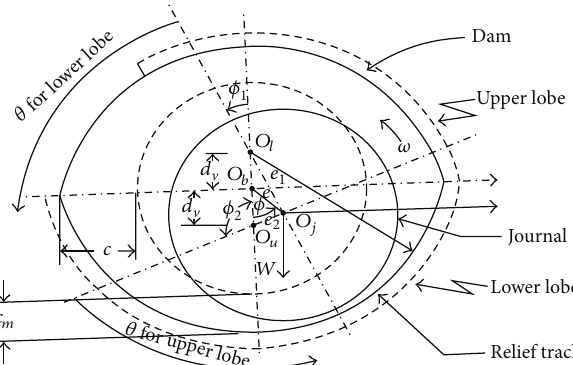
Figure 1: Two-lobe pressure dam bearing.